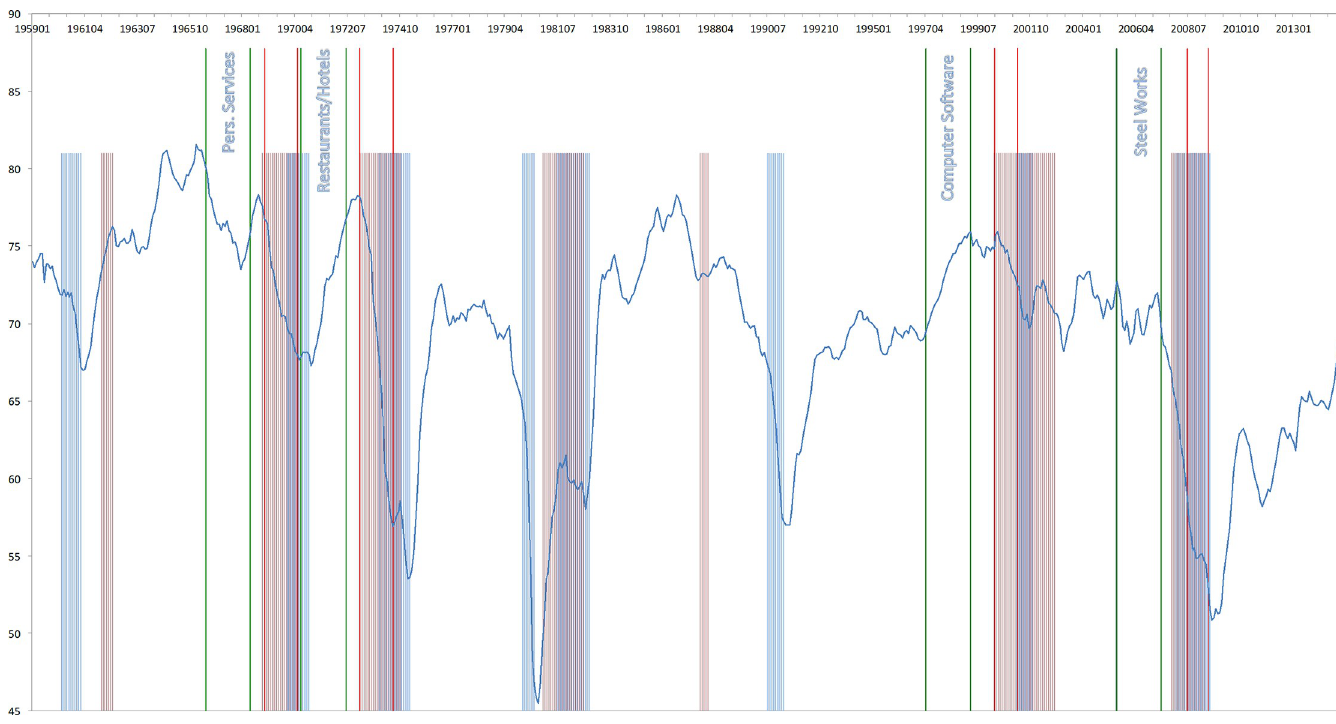
Fig 4. Euphoria Index and run-up/crash periods (1959–2014). The Figure depicts the level of the Euphoria Index during selected run-up and subsequent crash episodes for a time period 1959 until 2014. The highlighted areas present the NBER recession periods (in blue) and the S&P 500 bear markets (in red). For each bubble episode, the two green bars indicate the start and the end of the run-up period. The subsequent two red bars indicate the start and the end of the crash period. For each run-up/crash episode, the industry is mentioned.